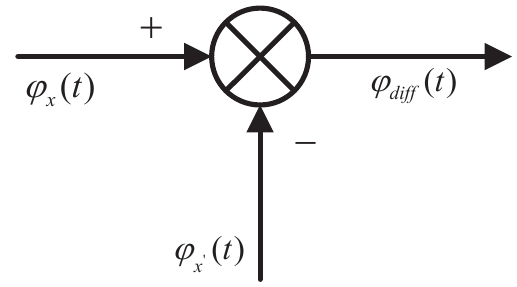
Figure 5. Mathematical model of the phase–frequency detector